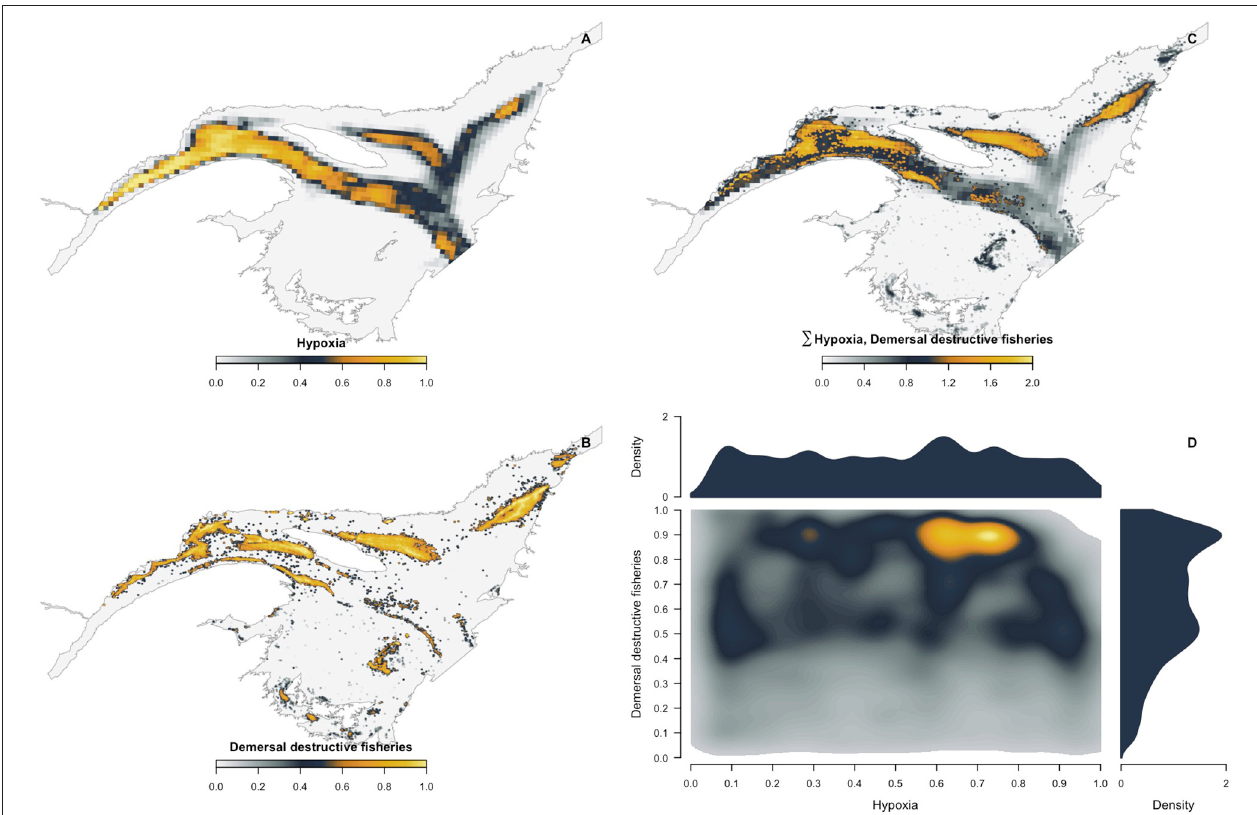
FIGURE 2 | Simplified 2-driver example of driver co-occurrence between hypoxia and demersal destructive fisheries in the St. Lawrence. An index of hypoxia (A) was created using bottom-water dissolved oxygen between 2013 and 2017 (Blais et al., 2019). Demersal destructive fisheries (i.e., trawl and dredges) (B) intensity was evaluated from fisheries catch data collected between 2010 and 2015 used to measure annual area weighted total biomass ( kg ) in 1 km 2 grid cells (DFO, 2016b). See Supplementary Materials for more information on specific methodologies. Relative hypoxic stress and demersal destructive fisheries intensity was summed (C) to visualize their combined spatial distribution and intensity. Finally, individual density and the co-intensity of hypoxia and demersal destructive fisheries was investigated with a two-dimensional kernel analysis (D) .